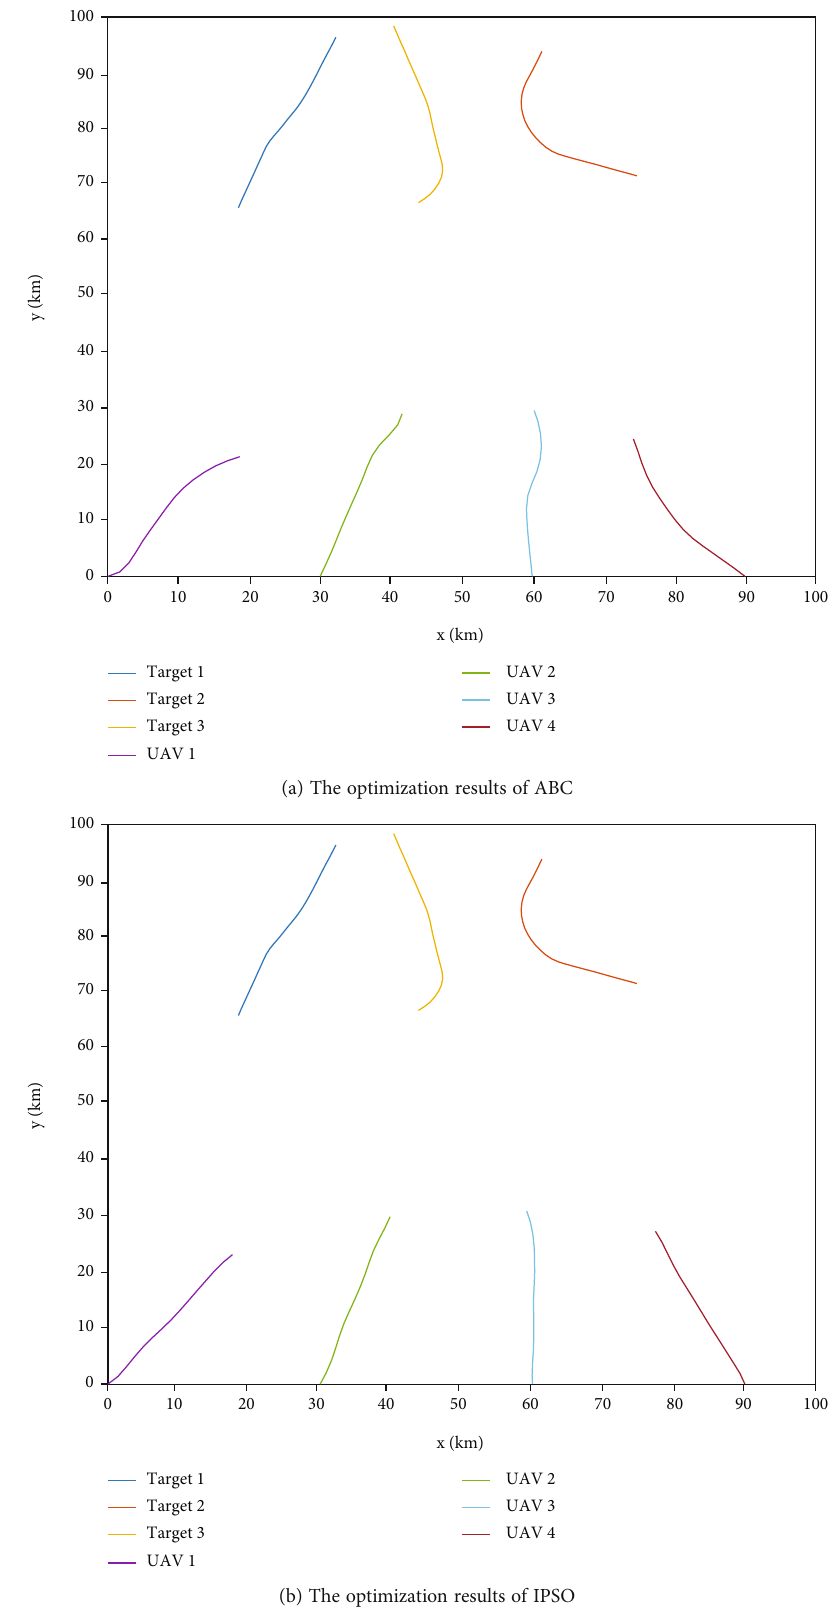
Figure 8: Comparison of the results of di ff erent